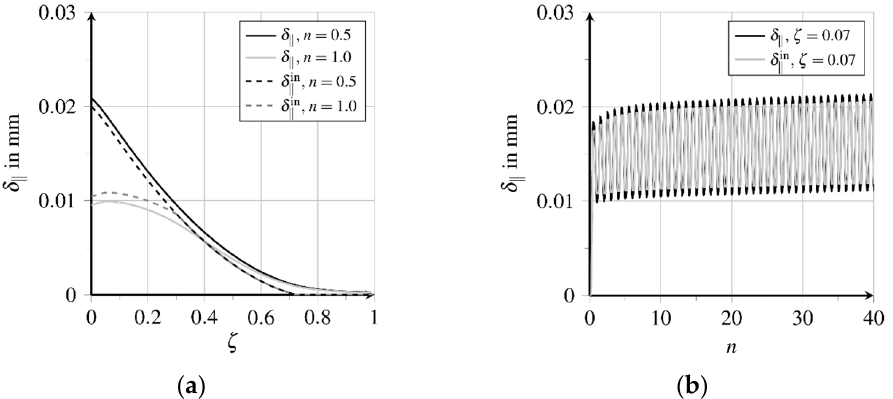
Figure 12. Evolution of relative displacements (adapted from [27]): ( a ) Displacement distribution over bond length in first load cycle and ( b ) displacement evolution near the fibre outlet at further load cycles.